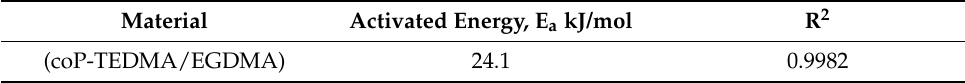
Figure 7. Arrhenius equation plot. Table 2. Activation energy and correlation coefficient values.